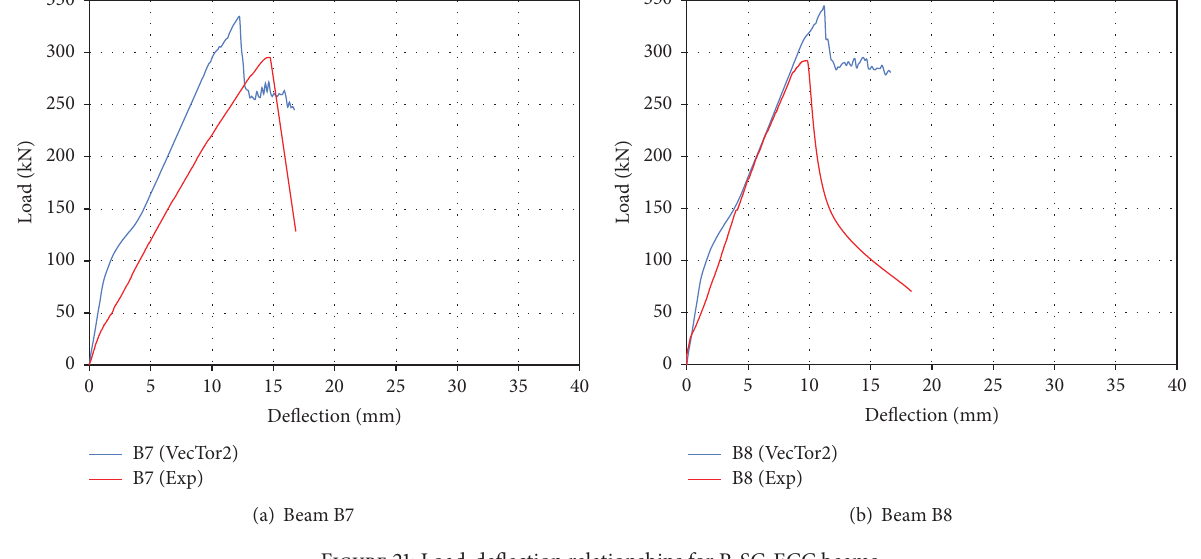
Figure 21: Load-deflection relationships for R-SC-ECC beams.